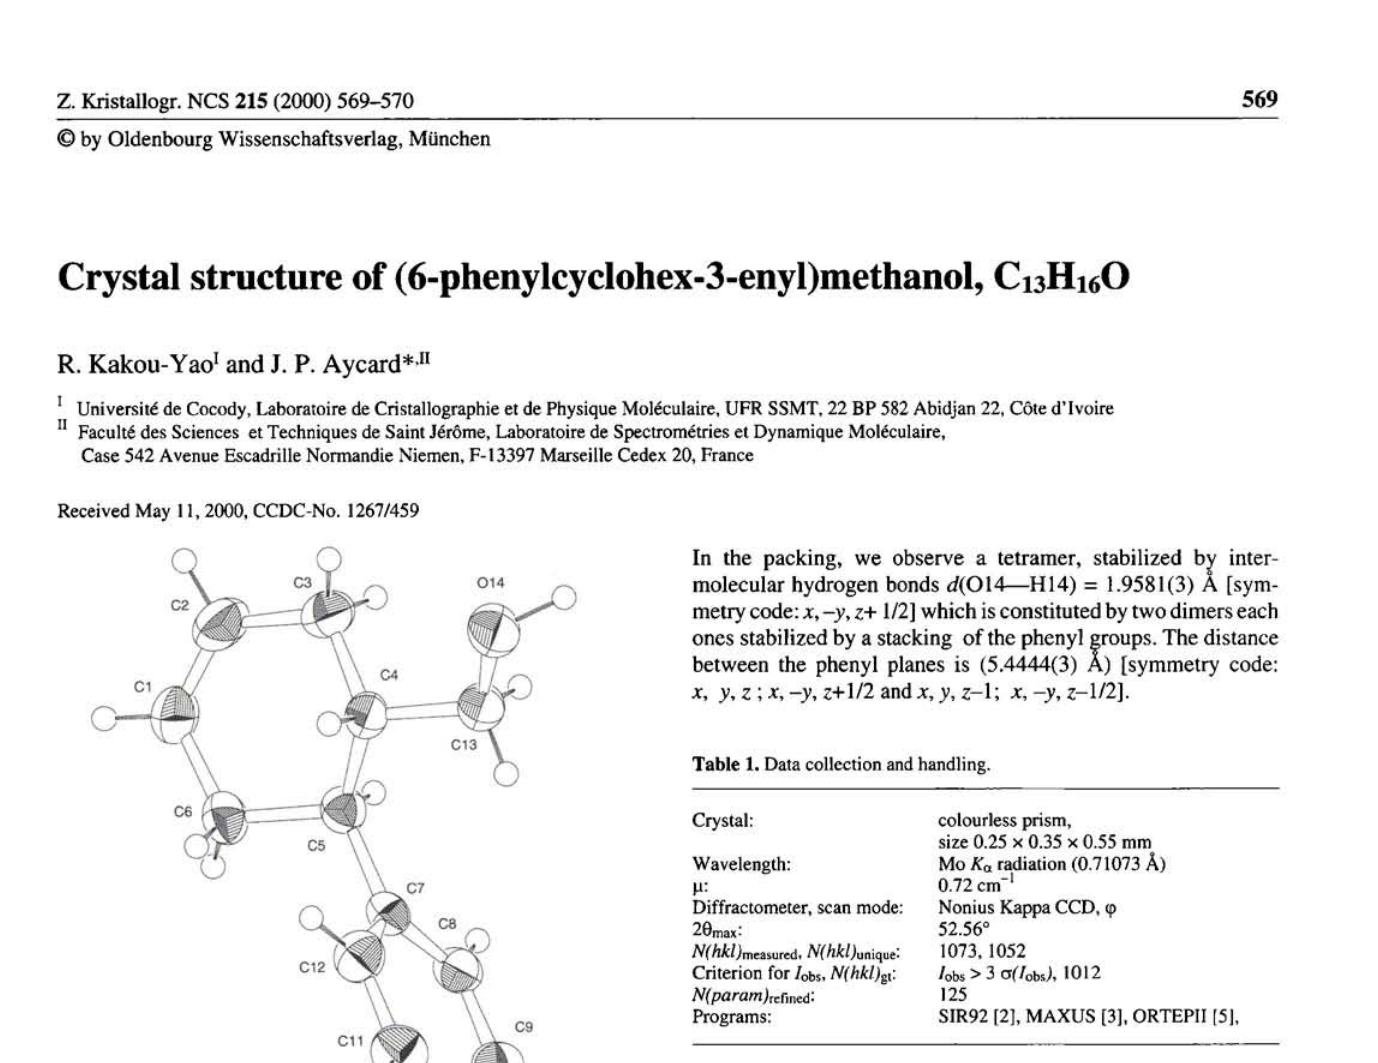
o 2 Table 2. Atomic coordinates and displacement parameters (in A